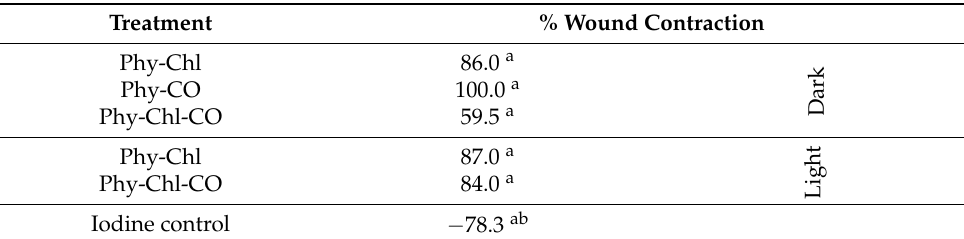
Table 6. Average lesions (percentages) contraction between the 1st and 21st day, considering six legs for each